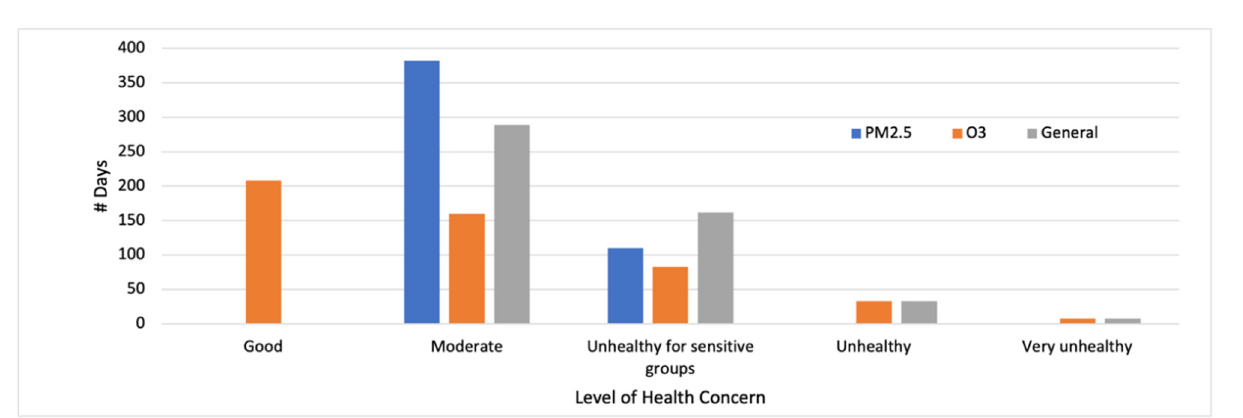
Figure 2. Number of days during warm months, Monterrey, Mexico, 2012–2015, for which different levels of health concern were indicated by the general, PM 2.5 , and O 3 AQI.